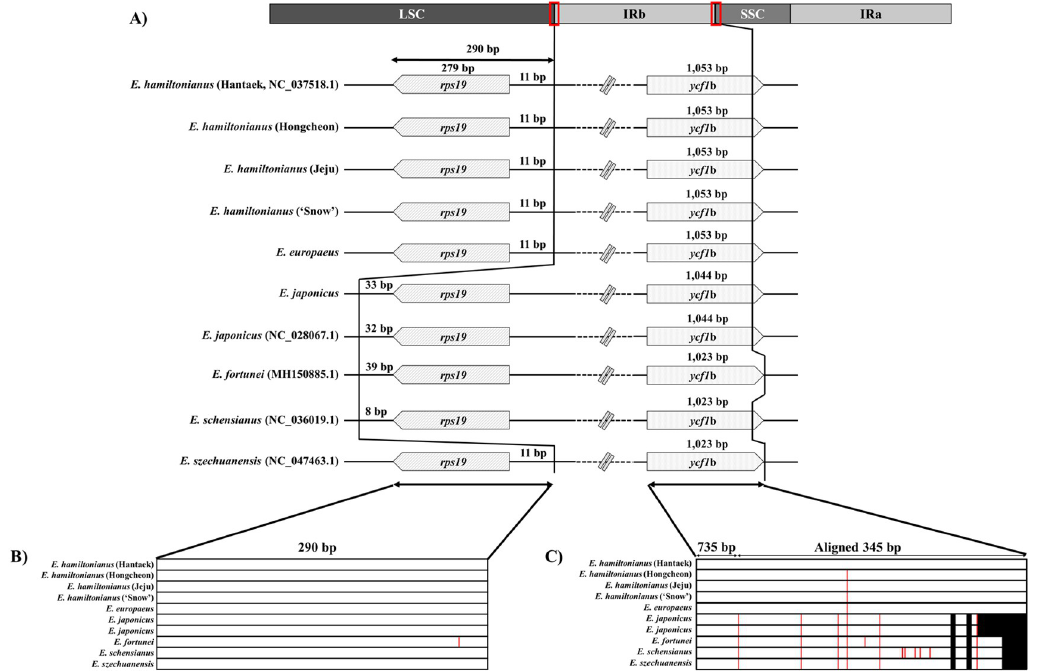
Fig 3. IR junctions in ten Euonymus plastomes. A) In every species, rps19 is 279 bp long and is present at the IR junction. rps19 is present in the IR in four Euonymus individuals and in the LSC in six Euonymus individuals. The right IR junctions on the ycf 1b genes are marked. B) and C) Nucleotide diversity in the left and right junctions, respectively. SNP and InDels are indicated by red and black lines, respectively. All variants are marked based on E . hamiltonianus (Hantaek) as a reference. The regions upstream of 735 bp in C) have no